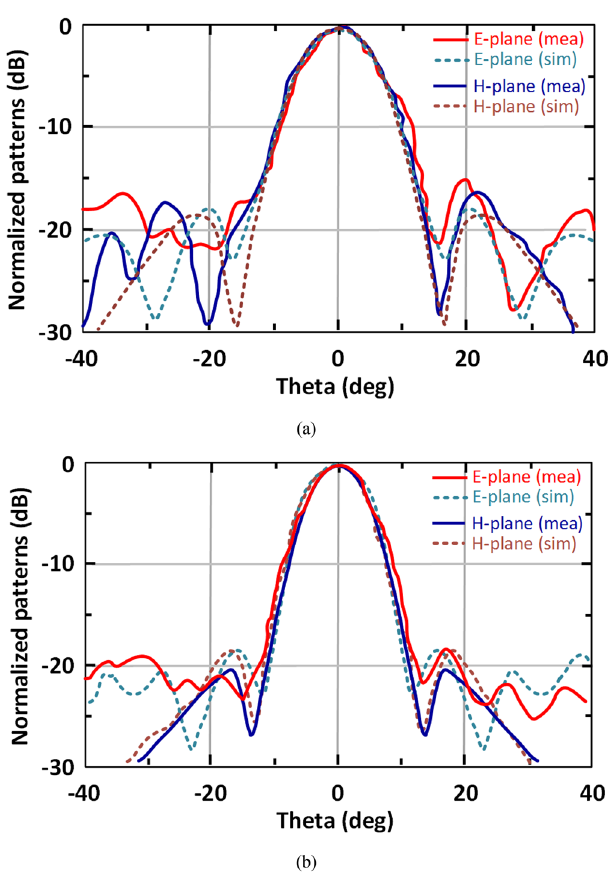
Figure 17. Measured and simulated radiation pattern of the 2 × 3 SIW-loaded MTM antenna arrays in E-plane and H-plane at ( a ) 190 GHz, and ( b ) 200